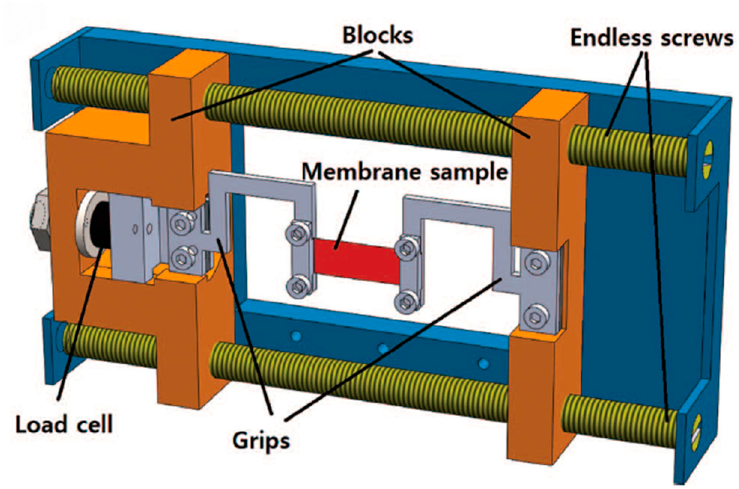
Figure 14. A load frame with U-shaped load beams that allow the sample to be deformed, whilst being completely immersed in water. The temperature-controlled reservoir containing H 2 O/D 2 O can be placed around the sample (reproduced with permission from [129], AIP Publishing, 2013).